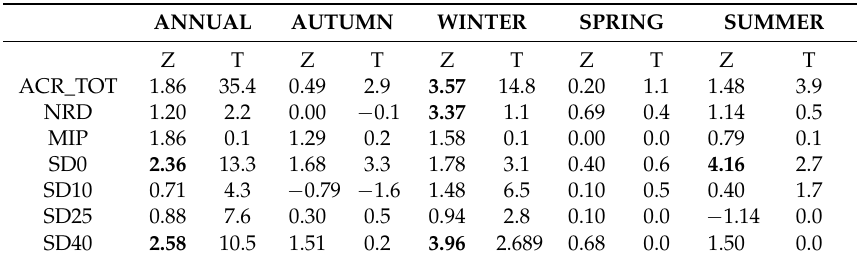
Table 4. Values of Z statistic and trend magnitudes of annual and seasonal observables. The Z values > 1.96 are reported in